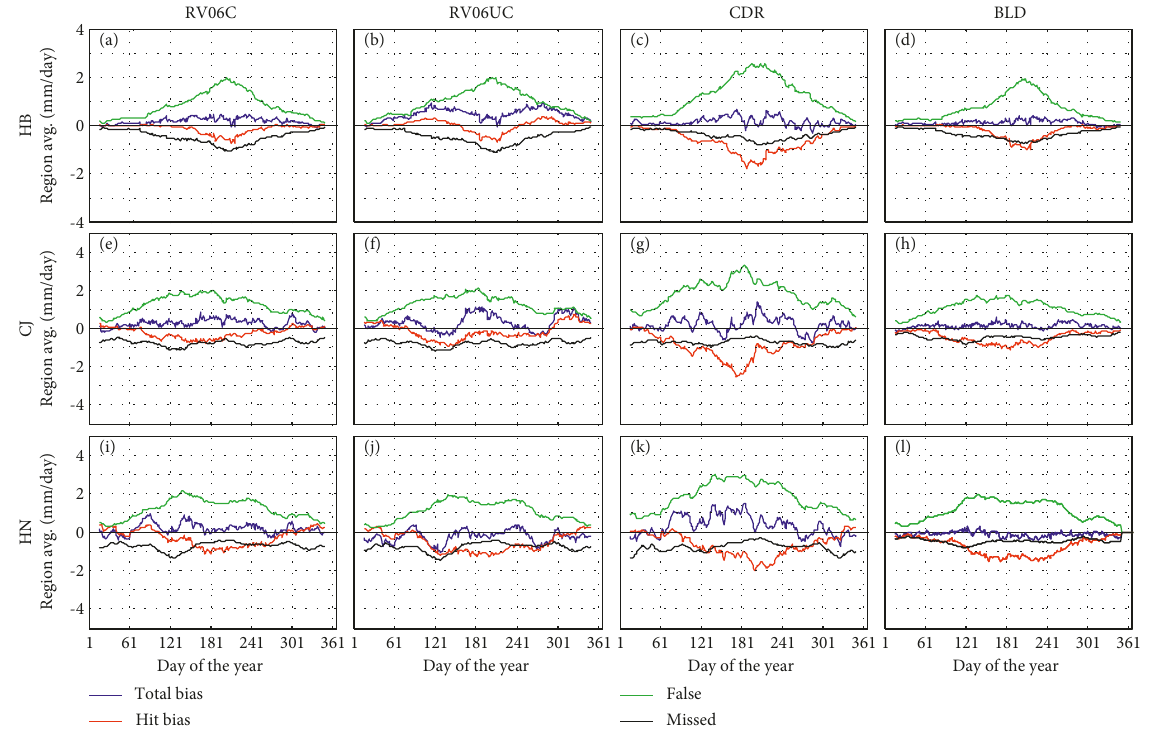
Figure 11: Same as Figure 10 except for the HB, CJ, and HN